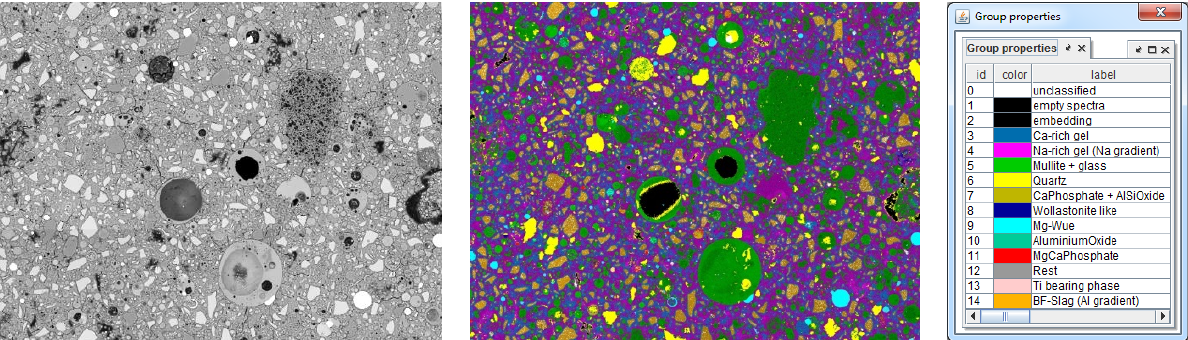
Figure 6. BSE image of the sample ( left ) and its corresponding PhAse Recognition and Characterization (PARC) phase map ( middle ). PARC legend ( right ) of different phases (groups) defined for the paste S50 (unsealed cured for 28 days) for the phase map (middle image).